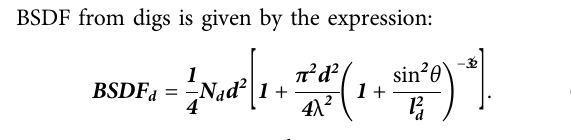
Frontiers in Physics |